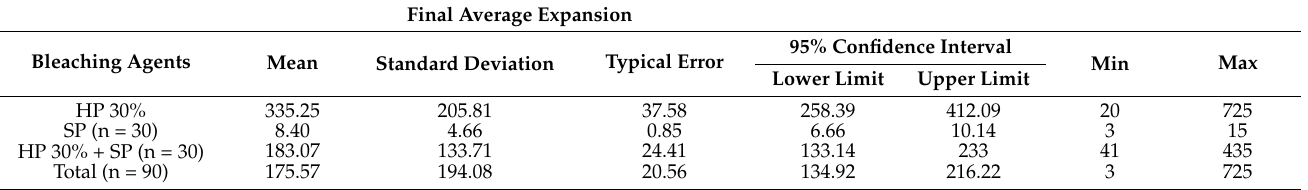
Table 1. Final average expansion after 10 days for each of the bleaching agents analyzed.